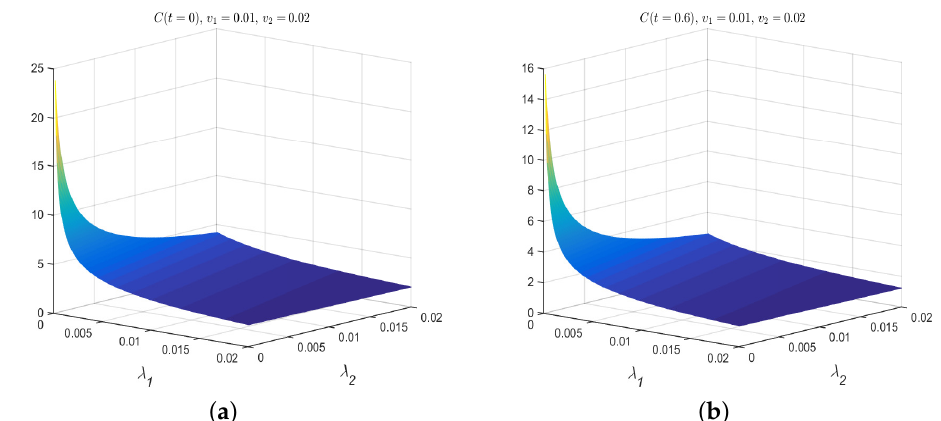
Figure 8. Time evolution of European call option price C ( t ) for fix v , t = 0 ( a ) and t = 0.6 ( b ) in the asymmetric case.